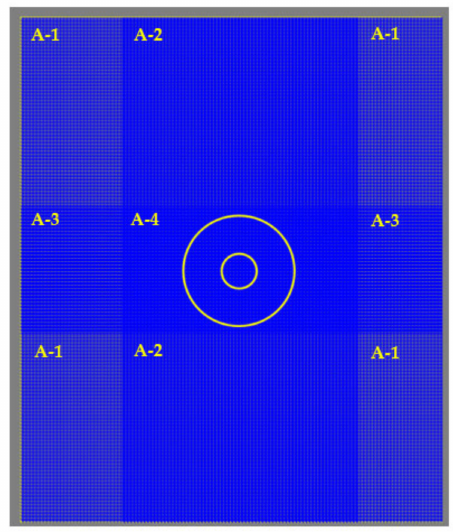
Figure 11. Discretization of the conic island domain using rectangular